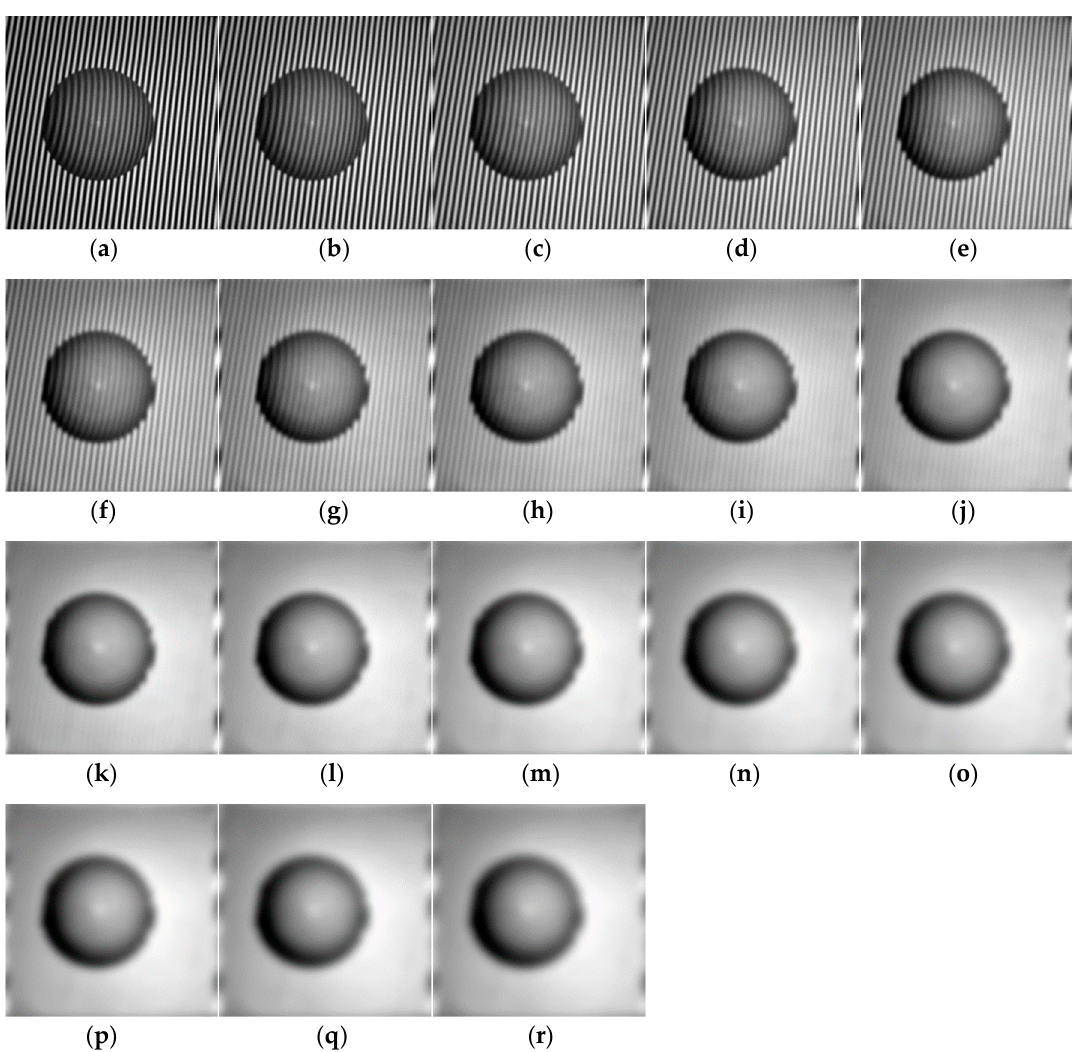
Figure A4. The decomposed background of Figure 3b by Fourier transform method with different parameter values. ( a – r ) are the decomposed background by Fourier transform method with 1th to 18th of filtering window sizes of [6:2:40], respectively.